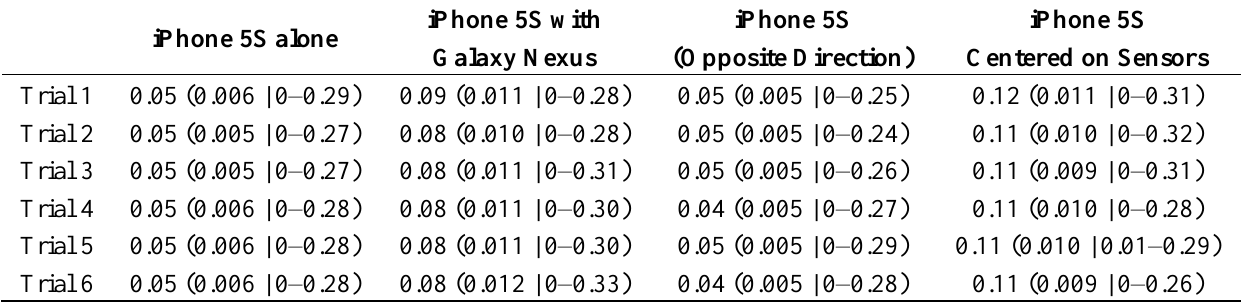
Table 2. Effect of position, RMS (min–max) for pitch in degrees. Bold typesetting indicates a statistically significant difference with the gold standard ( p <